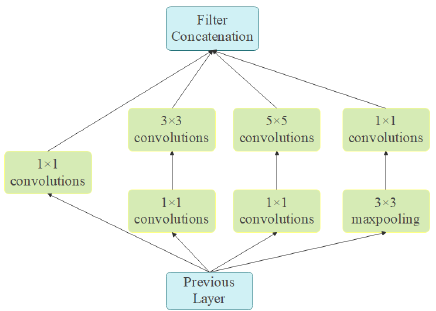
Figure 10. Inception structure.